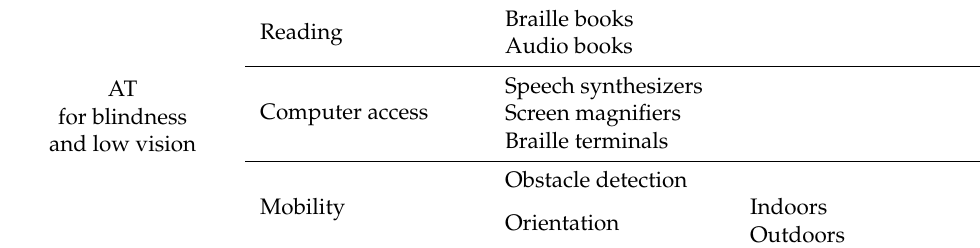
Table 1. AT for blindness and low vision: main research